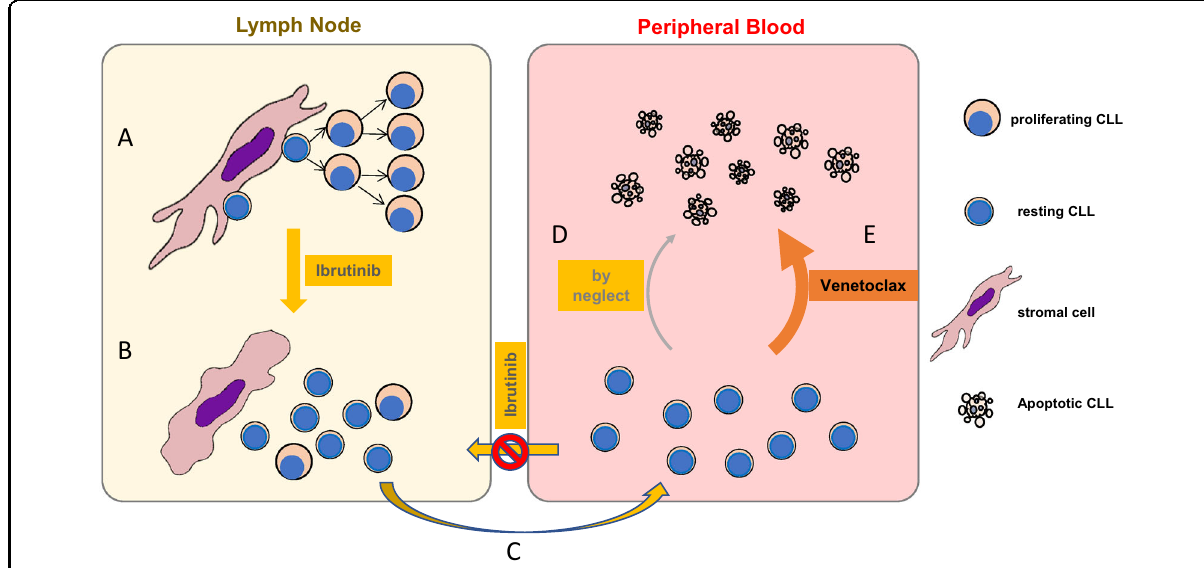
Fig. 7 A schematic diagram of tumor cell dynamics under ibrutinib or venetoclax treatment. A In lymph nodes, with close contact between tumor and stroma, CLL cells are well supported and proliferate. B With ibrutinibutinib treatment, adhesion to stromal cells is disrupted and proliferation is halted. C CLL cells are released to the periphery where they are also prevented from homing back to LN by the action of ibrutinibutinib on chemokine signaling. D In the periphery, without the supporting tumor microenvironment, the cells become non-proliferating/ resting and die by neglect over a long period of time. E In the presence of venetoclax, however, these resting cells are subjective to active killing, causing tumor lysis syndrome and disease